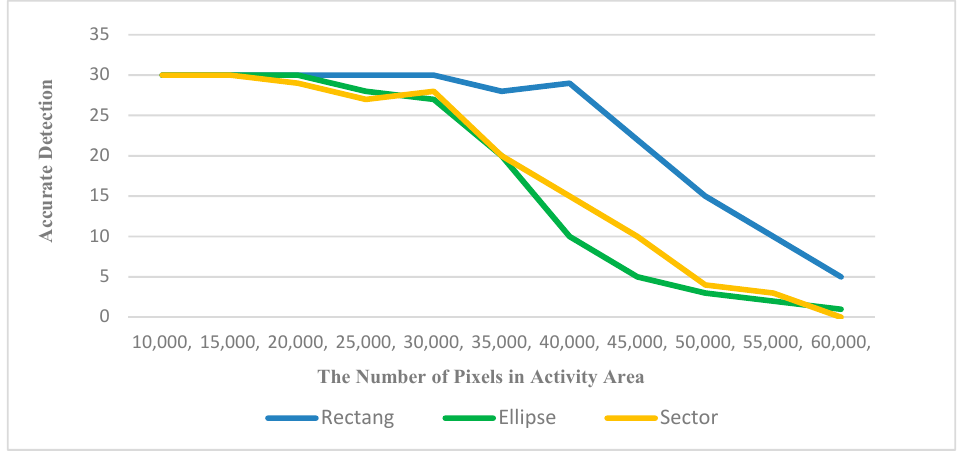
Figure 12. Active area threshold area setting.